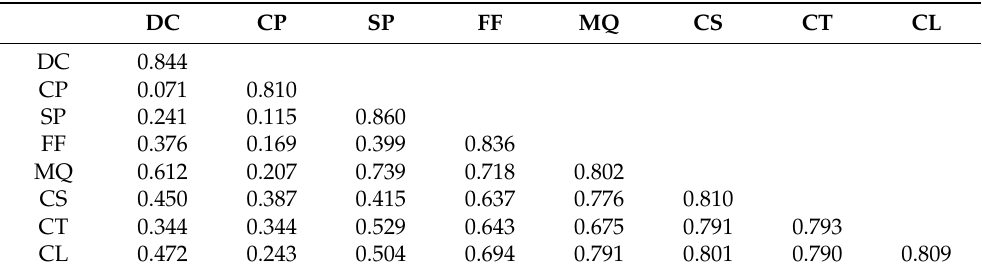
Table 5. Fornell–Larcker Criterion Analysis for Discriminant